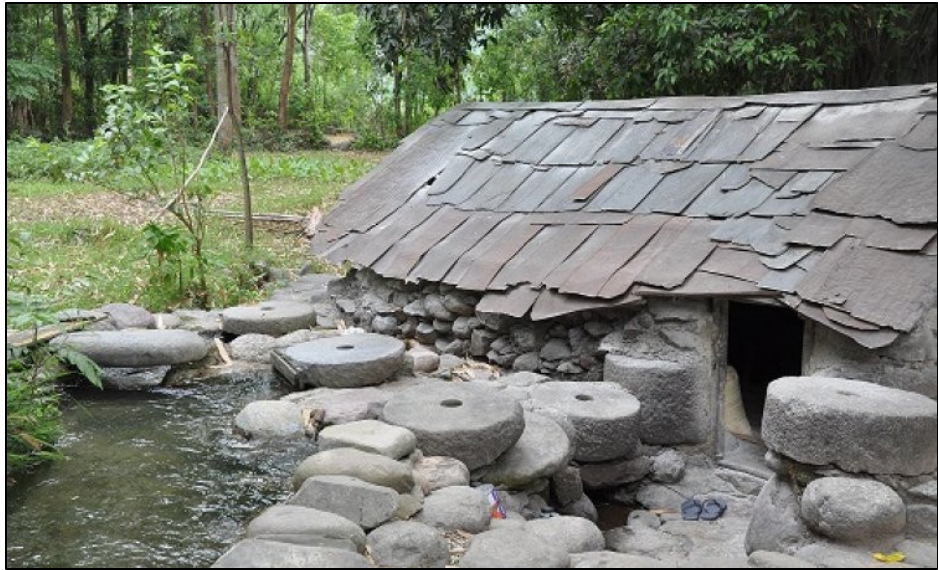
Figure 11. Gharats use waterpower used to grind grains in hilly areas (adapted from [30]).